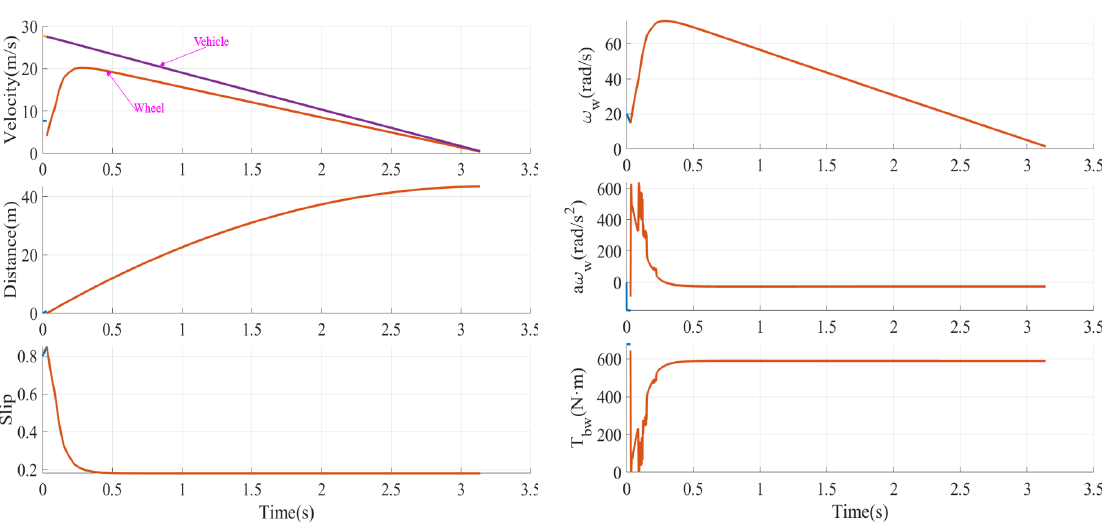
Figure 14. SMWSC control on dry roads with v 0 = 100 km/h.